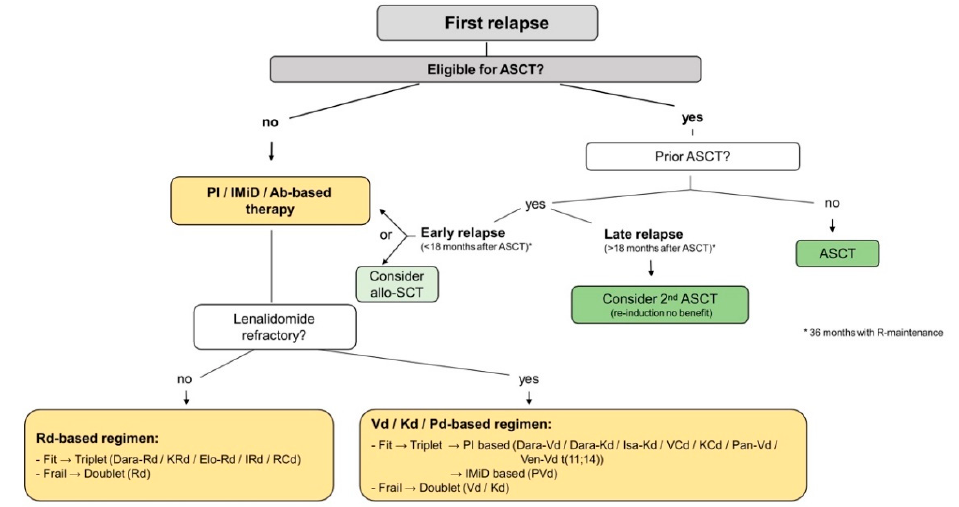
Figure 3. Treatment algorithm for RMM—1st relapse. Treatment algorithms for patients at first relapse aid in the process of decision-making and present numerous therapeutic options to be discussed with the patient. Relevant parameters for the use of a subsequent line of therapy are the duration of response to the last treatment, the eligibility for auto- or allo-SCT, the use of novel agents in first line therapy and its tolerability and achieved time of remission. Abbreviations: Ab = Antibody, allo-SCT = allogeneic stem cell transplantation, ASCT = autologous stem cell transplantation, Dara-Kd = dara-